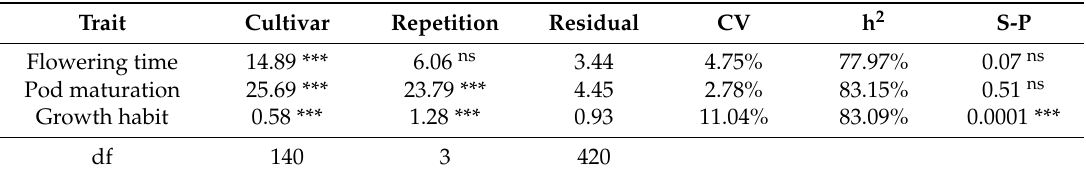
Table 3. Variance analysis (ANOVA) for the traits of flowering time, pod maturation, and growth habit for the Carioca panel ( n = 141), demonstrated by the mean squares.